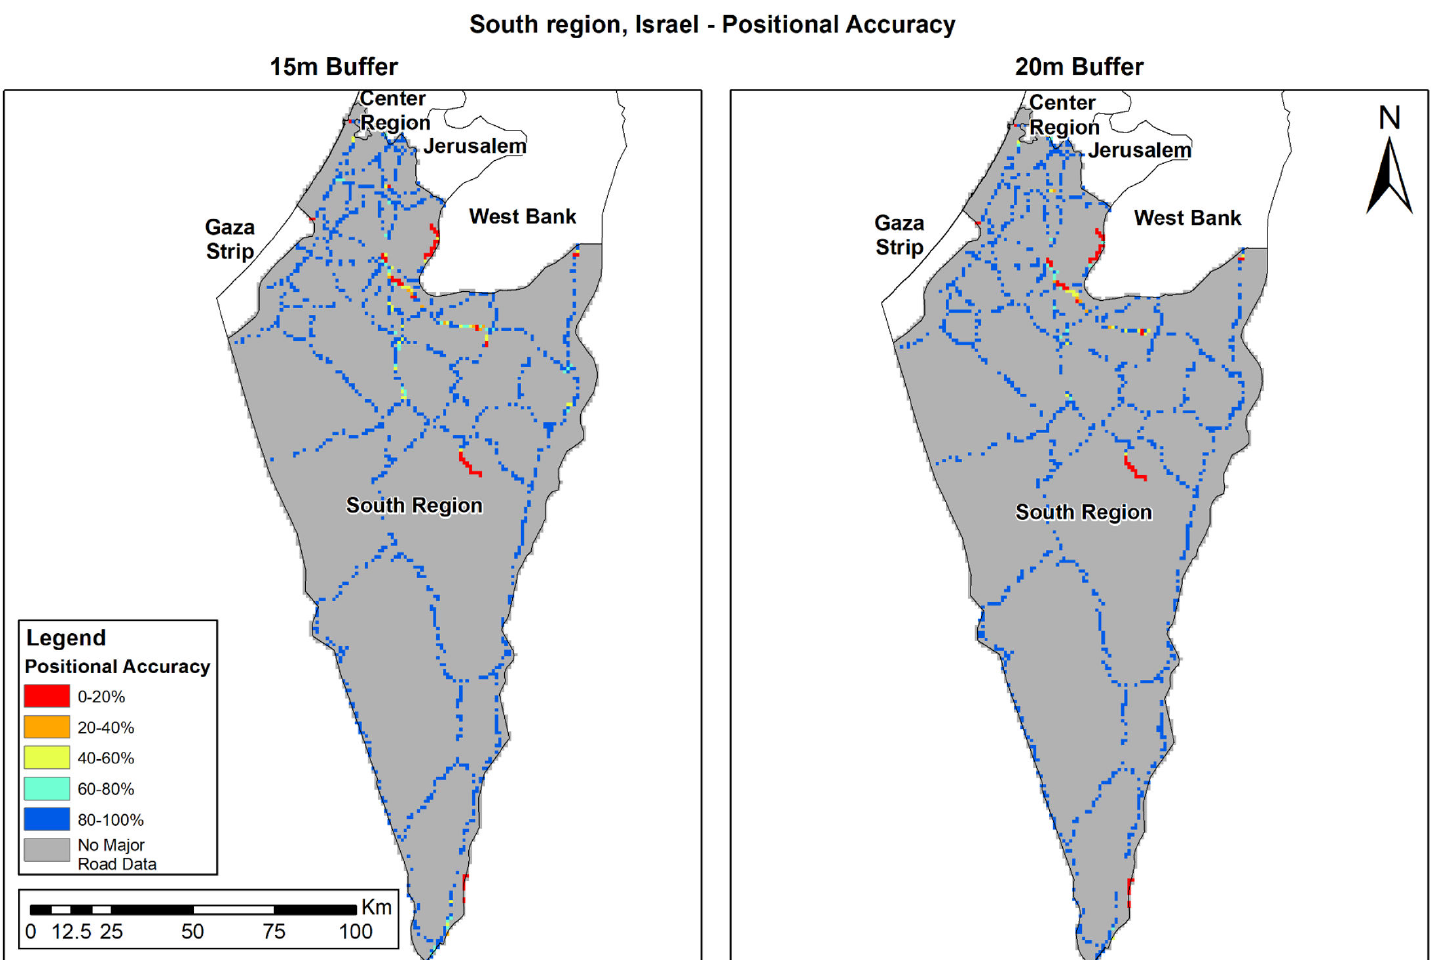
Figure 7. Israel’s south region’s PA (%): 15 m ( left ) and 20 m ( right )